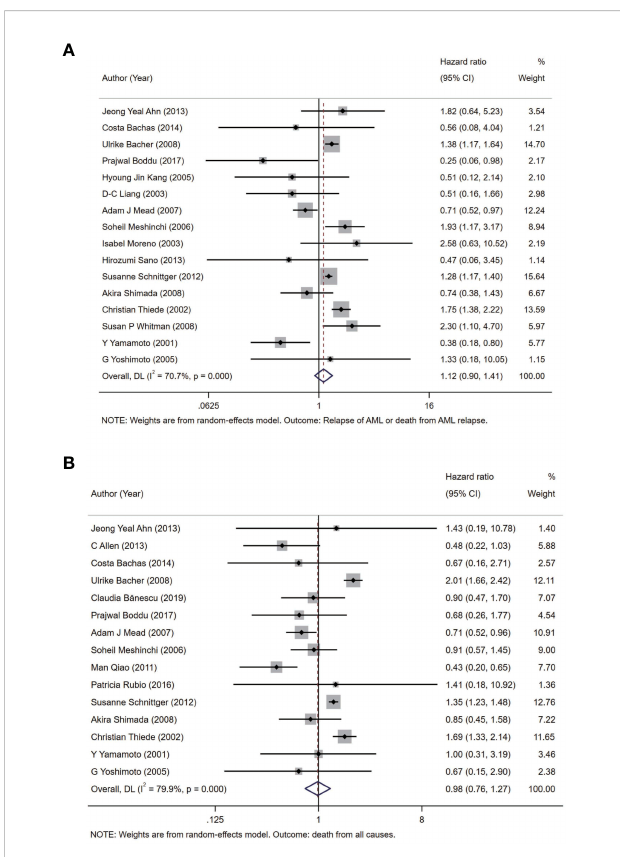
FIGURE 2 Forest plots of HRs and 95% CI for DFS (A) and OS (B) in patients with AML. The size of blocks or diamonds represents the weight in this meta- analysis, and the length of straight line segment represents the width of 95% CI. HR, hazard ratio; CI, con fi dence intervals; DFS, disease-free survival; OS, overall survival; AML, acute myeloid leukemia.